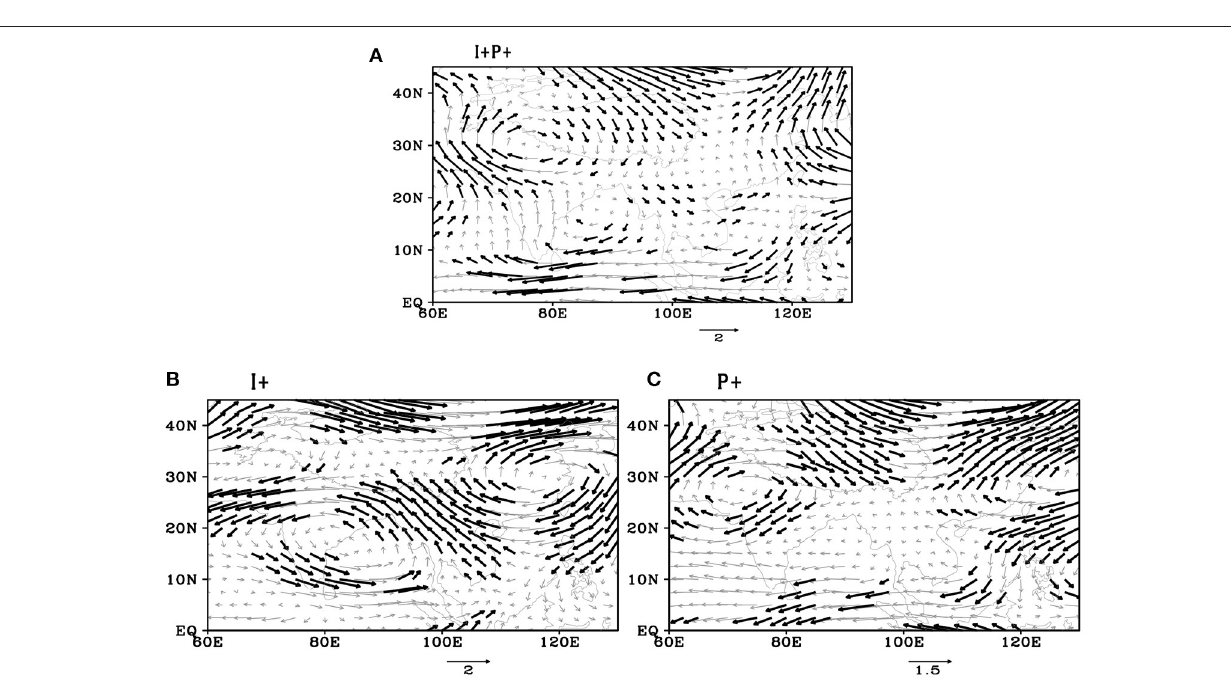
It is also noted that there is an uncertainty in the CAM5 model in climate simulation, especially for the middle- and high-latitude regions, which may lead to a certain bias in the simulated results presented in this study relative to the